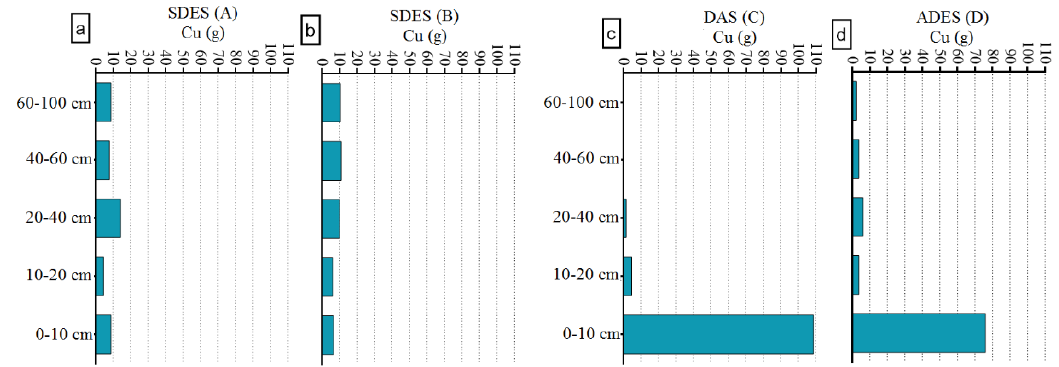
Figure 8. Fate of Cu in reactors: ( a ) A-SDES; ( b ) B-SDES; ( c ) C-DAS; ( d ) D-ADES.